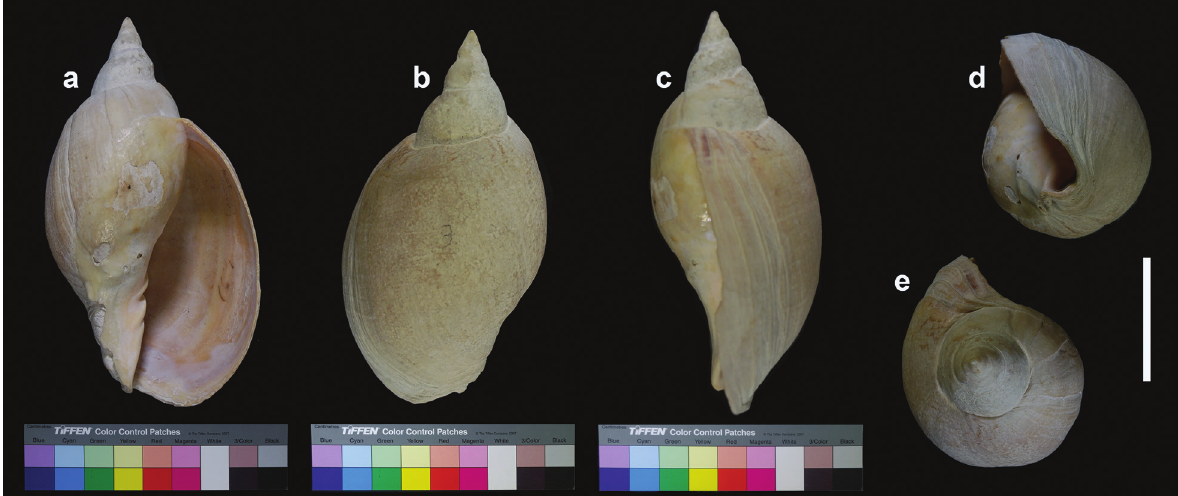
Figure 43. Voluta magellanica taeniolata , holotype figured by Lahille (1895: pl. VII, fig. 154) a Apertural view b Dorsal view c Lateral view d Umbilical view e Apical view. Scale bar: 5 cm.